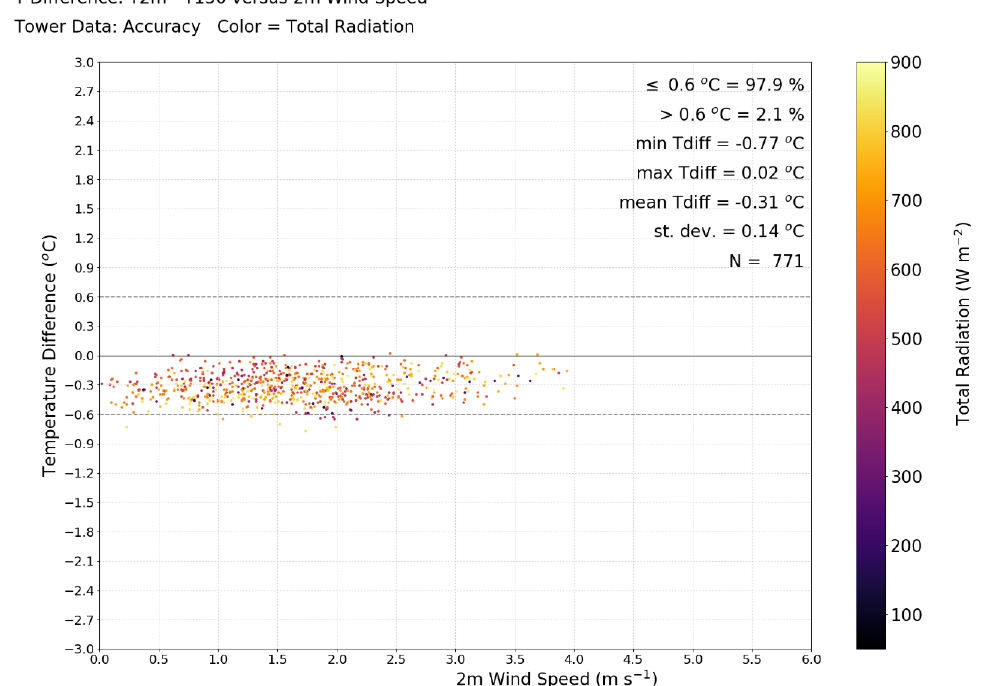
Figure 11. Temperature difference (°C) between the 2m and 1.5m temperature sensors (T 2m –T 1.5m ) on the Mesonet tower as a function of 2 m wind speed (m s −1 , x-axis) and solar radiation (W m −2 , colors).